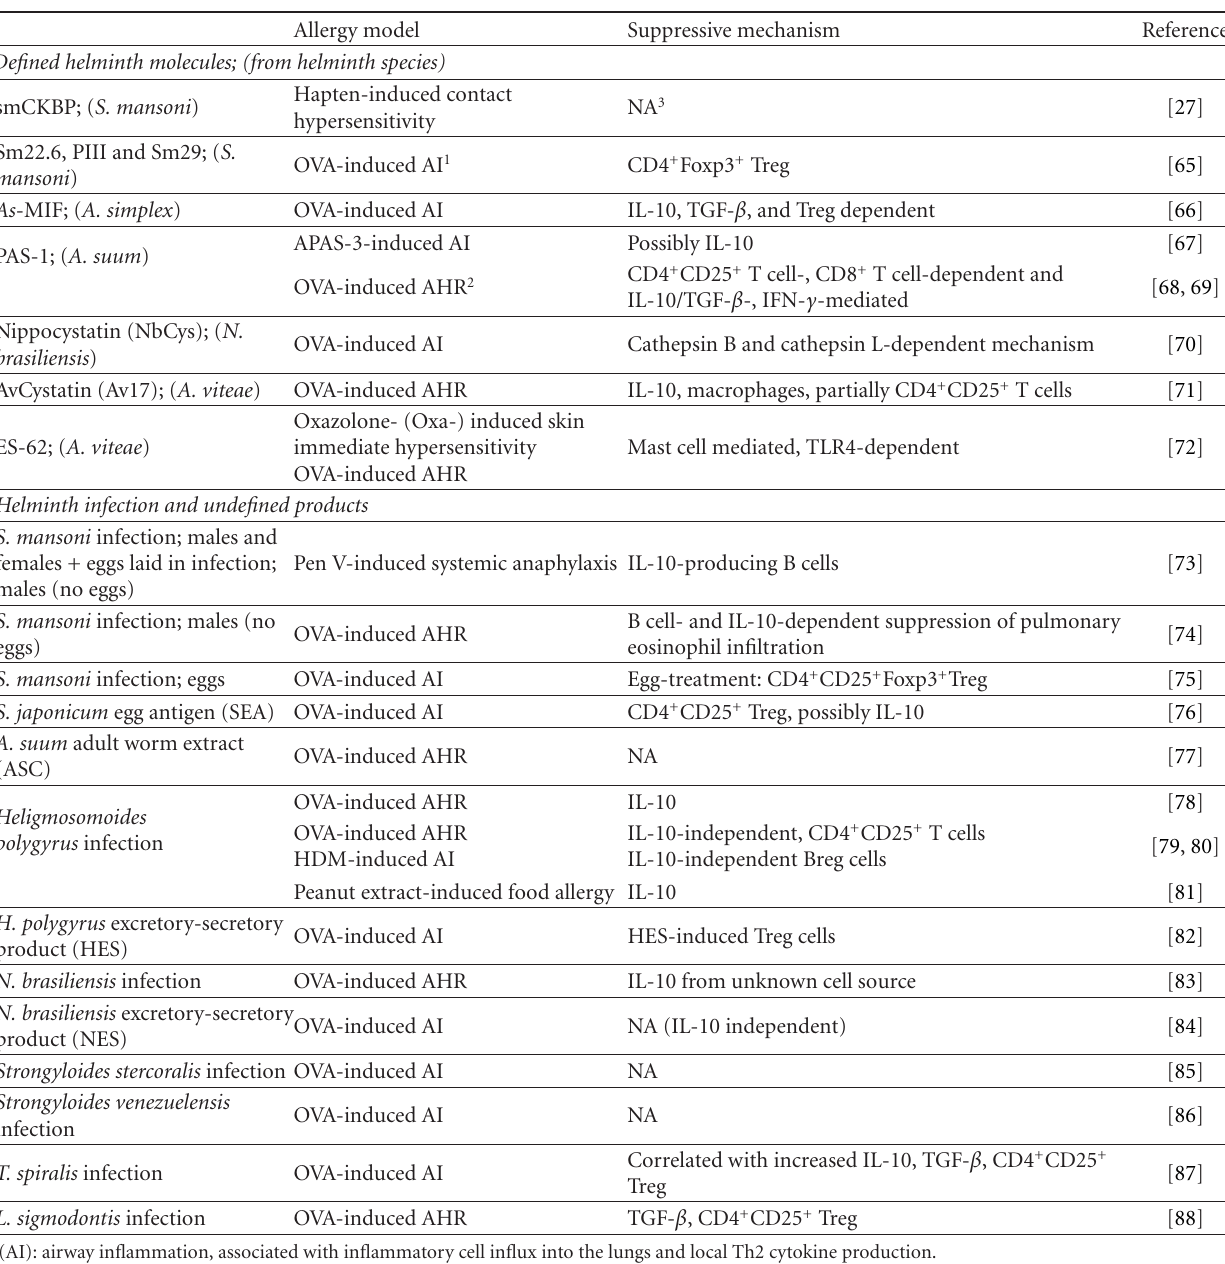
Table 2: E ff ects of helminth infections and helminth-derived products/molecules on improvement of symptoms in allergy-related experimental animal